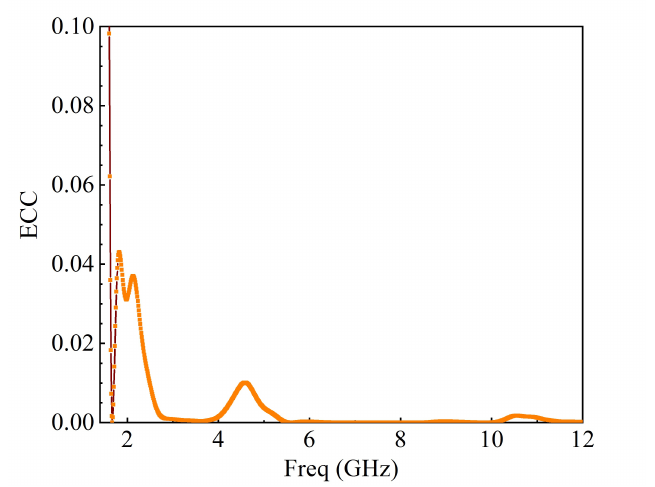
Figure 29. Envelope correlation coefficient (ECC) of MIMO antenna